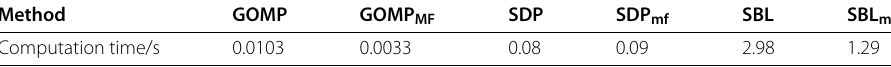
Table 1 Computation time of the